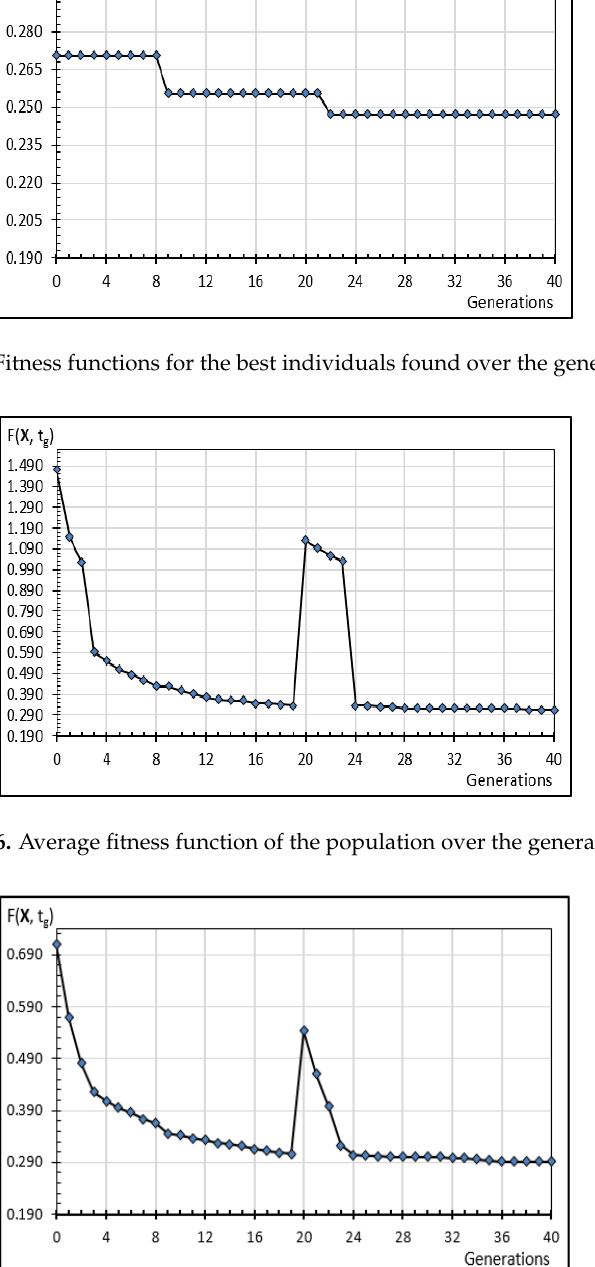
Figure 7. Fitness function of the worst individual found over the